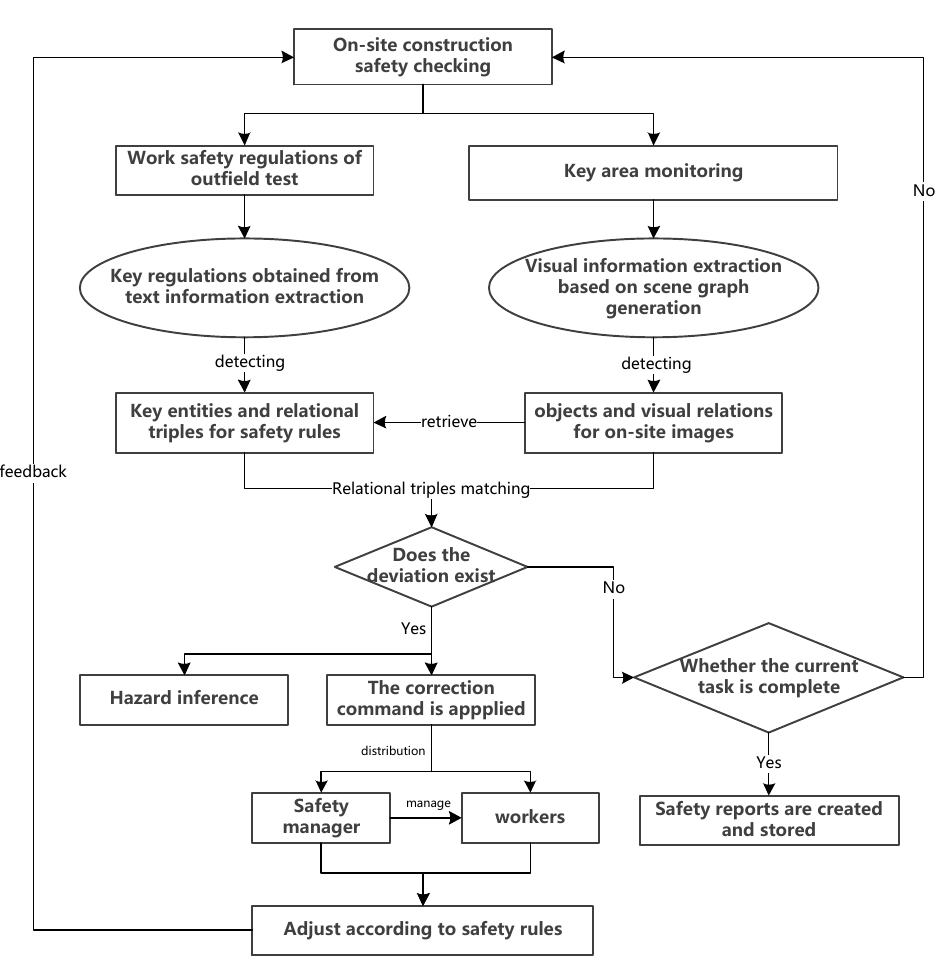
Figure 5. The flowchart of the work safety checking